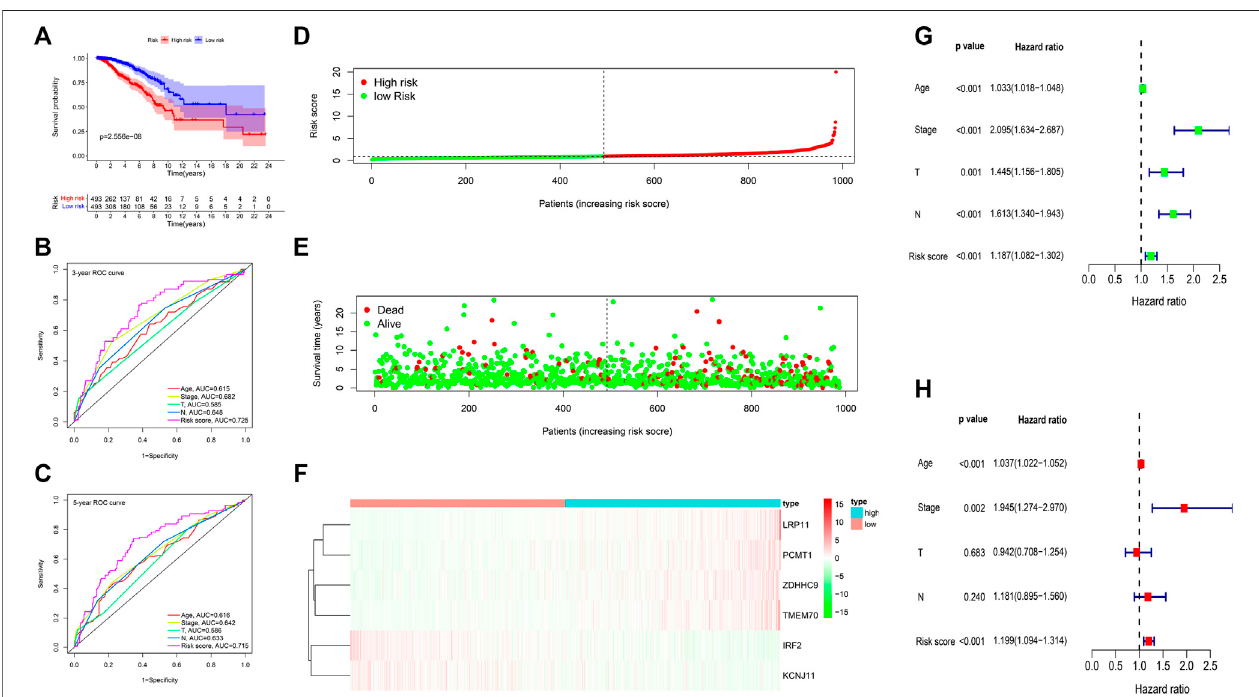
FIGURE8| Geneprognosticsignatureassessmentof986breastcancersamples. (A) Survivalanalysisbetweenthehigh-riskandlow-riskgroups. (B,C) Thetime- dependent receiver operating characteristic (ROC) curves at 3 and 5 years. (D) The risk score distribution. (E) Survival status scatter plot. (F) Heatmap of the six prognostic genes. (G) Univariate Cox regression analysis. (H) Multivariate Cox regression analysis.